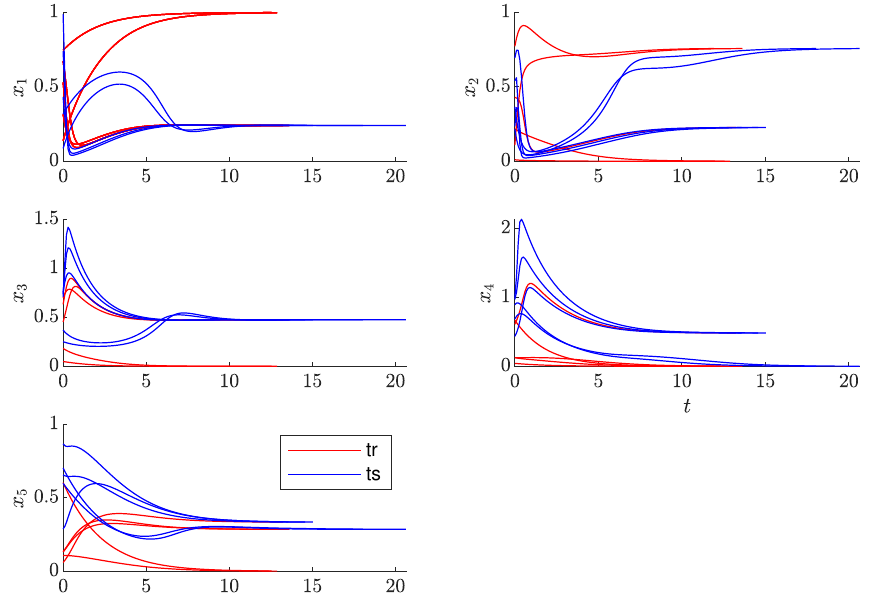
Figure 6. Training and testing trajectories of the biochemical reaction